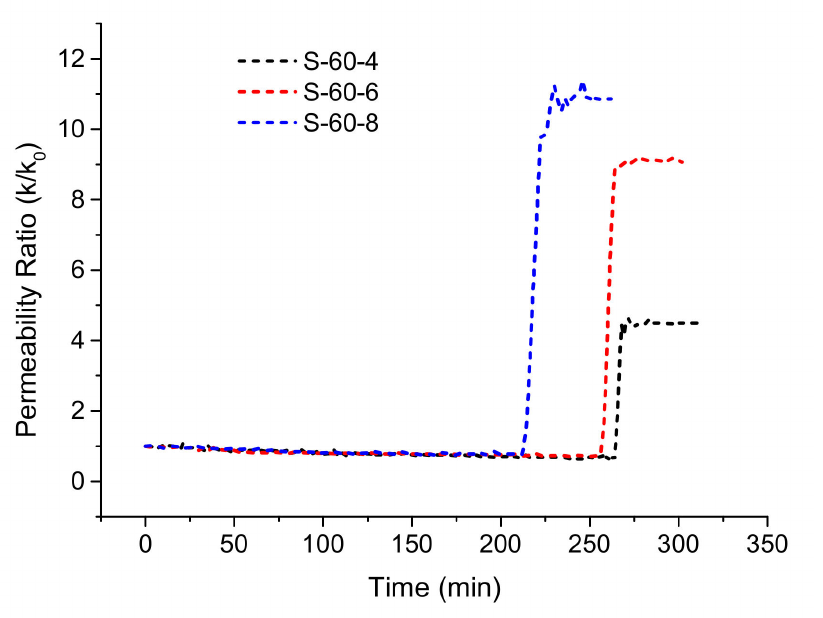
Figure 4. Evolution of the coal permeability ratio with time under different N 2 injection